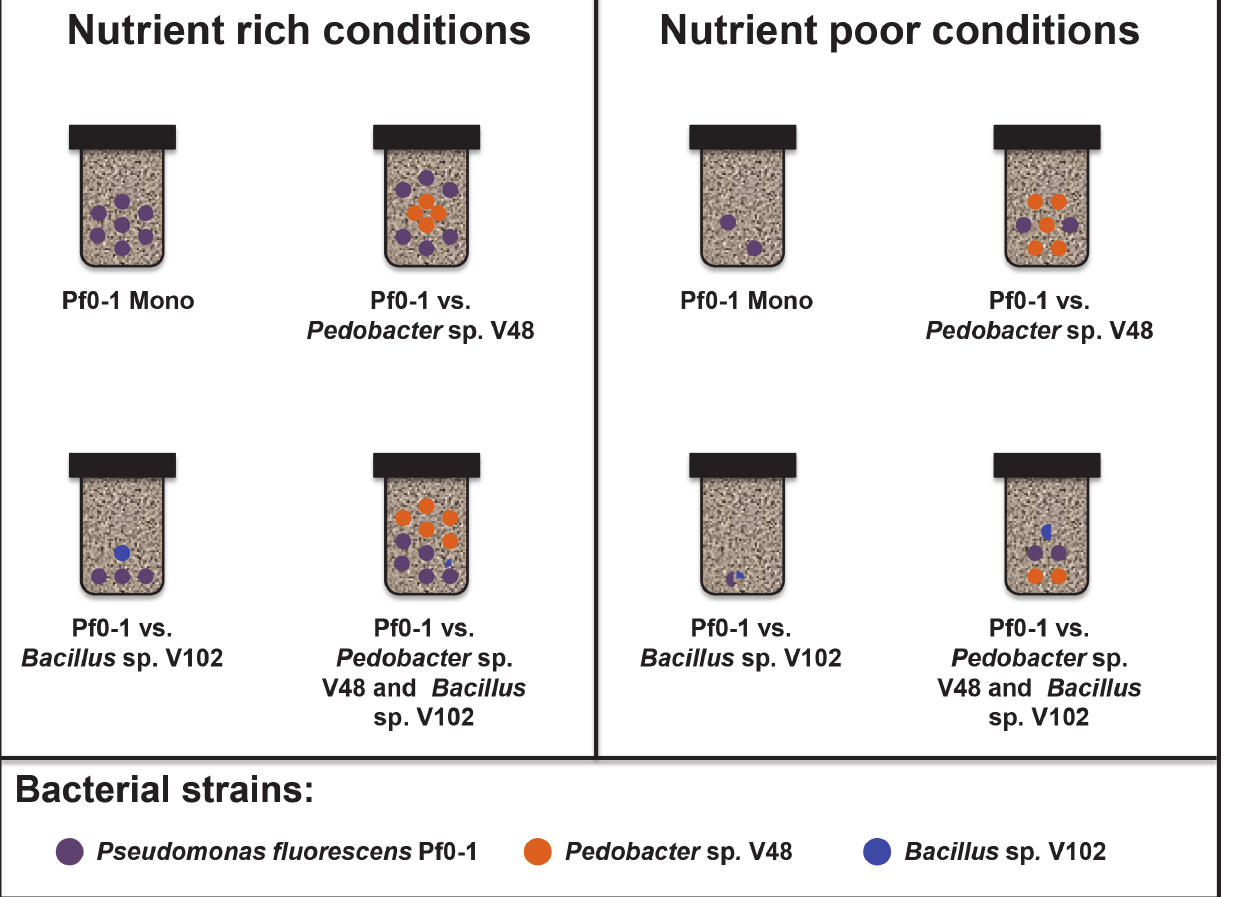
Fig 3. Schematic representation of the fitness of Pseudomonas fluorescens Pf0-1 during inter-specific interactions with either Pedobacter sp. V48 or Bacillus sp. V102 (2-way interaction) or with both strains together (3-way interaction) at day 6. The effects of the respective interaction on the fitness of Pseudomonas fluorescens Pf0-1 are indicated by the number of the colored circles. Each full circle represents 1.0 * 10 5 CFU/mL (nutrient rich media) or 1.0 * 10 4 CFU/mL (nutrient poor media).